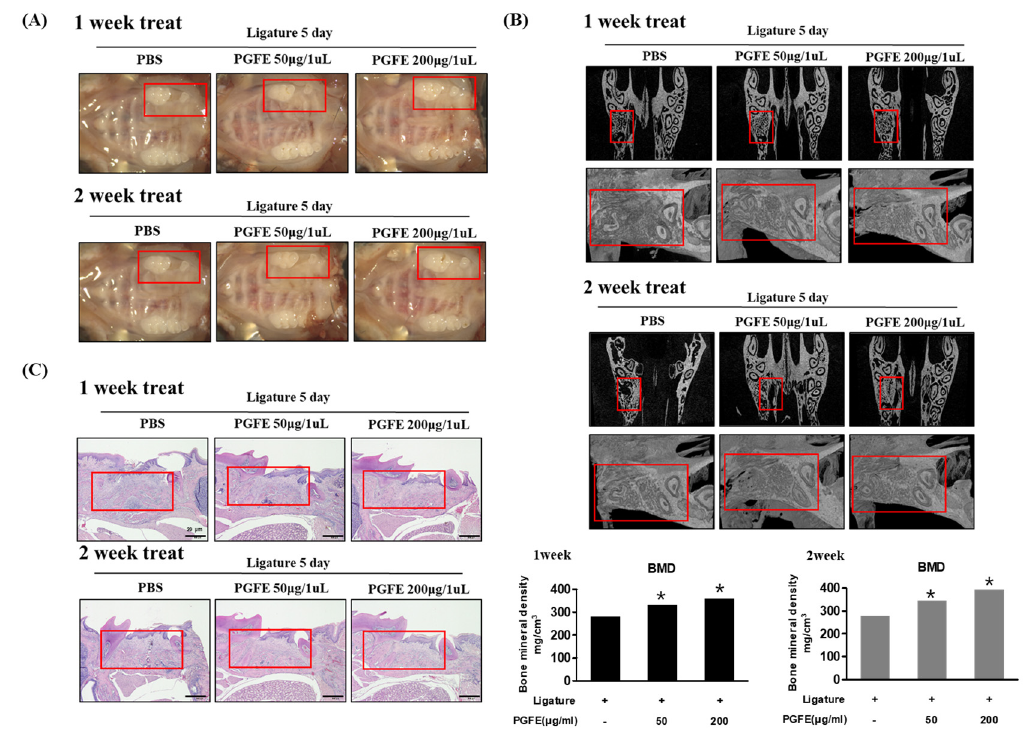
Figure 8. Inhibitory e ff ect of PGFE on periodontitis in a ligature-induced in vivo model. ( A ) Induction of periodontitis; microscopic photographs of PGFE at the indicated concentration in the extraction socket (red area) of the second molars were treated for 1 or 2 weeks. ( B ) Micro-CT (computed tomography) analysis of newly formed bone by extraction socket (red area) and PGFE. Analysis tables were determined using CTAn software. ( C ) Histological analysis of the periodontium using hematoxylin and eosin (H&E) staining. * p < 0.05 vs. only phosphate-bu ff ered saline treated group. Scale bars denoted 20 µm.